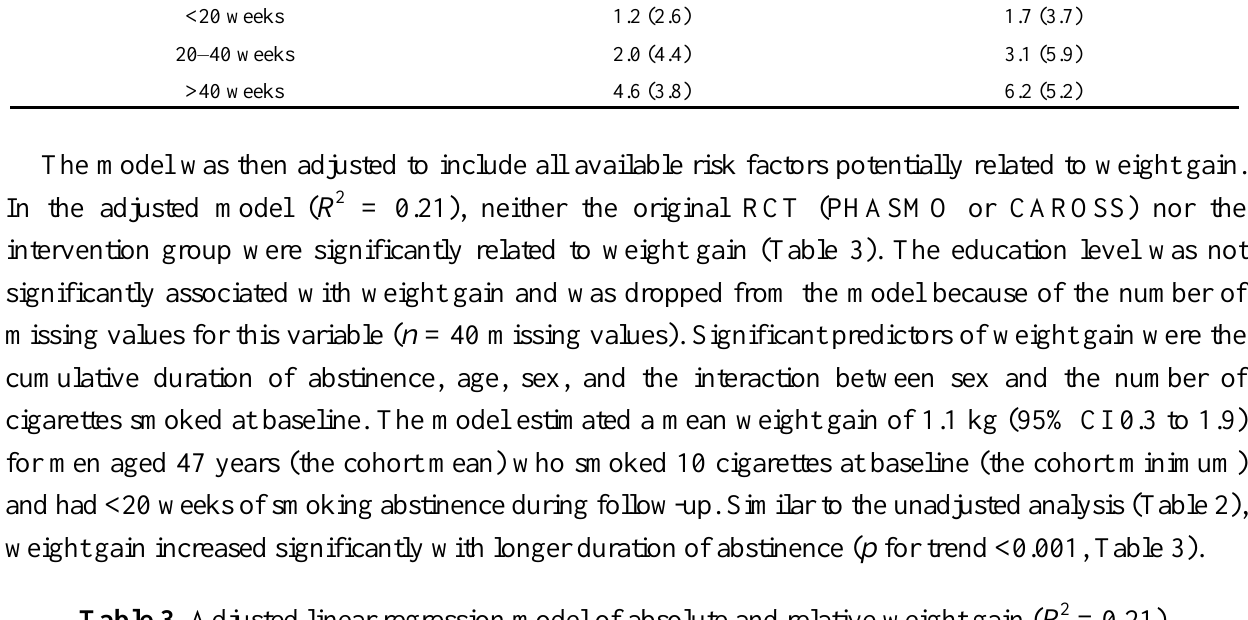
Table 2. Absolute and relative weight gain for categories of overall duration of abstinence. Cumulative Duration of Abstinence, No. (%)